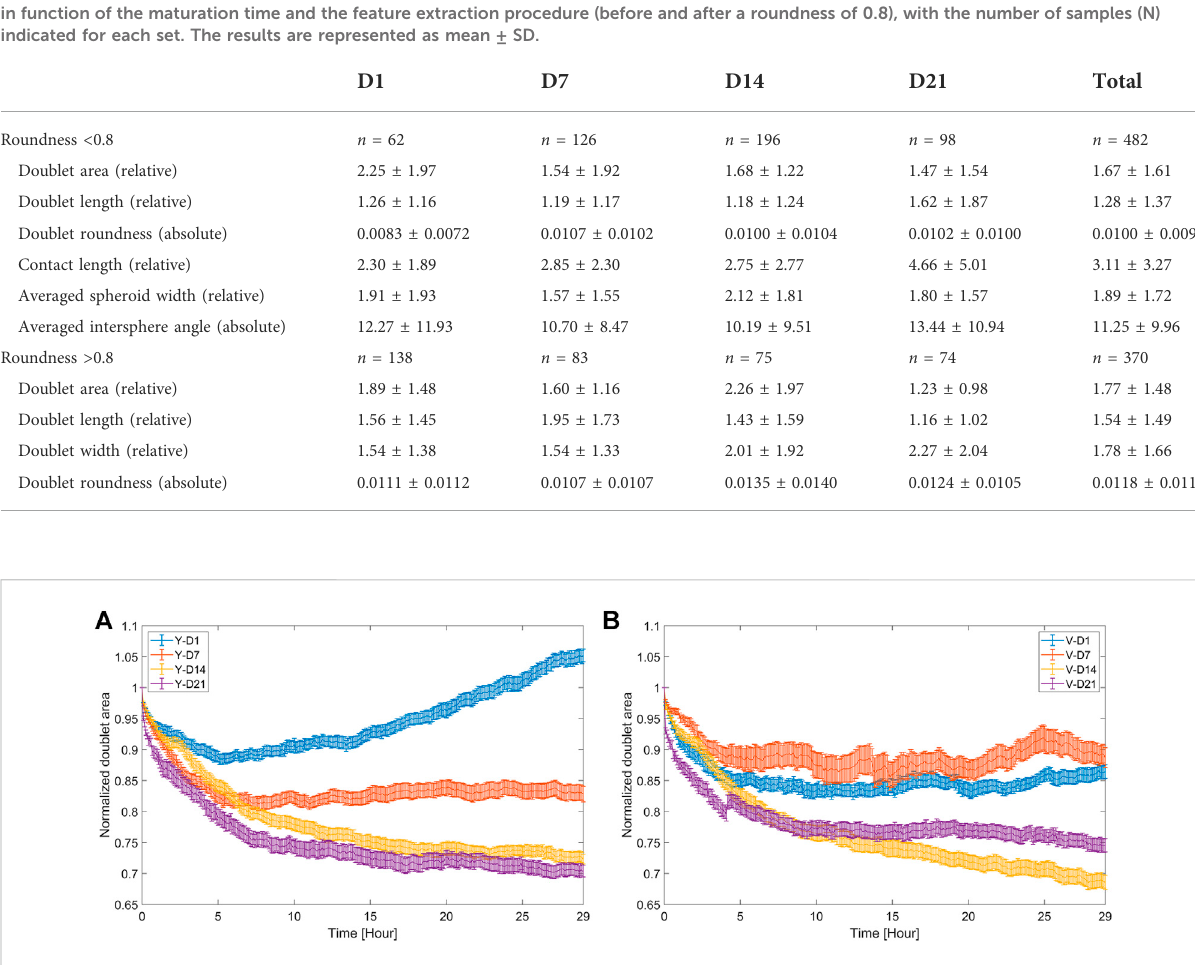
FIGURE 5 Arearesponseofdoubletsduring fusion.Doubletareanormalizedwithrespectto theinitialarea(meanvalue±SEM, n =20 – 35)for (A) Yand (B) V